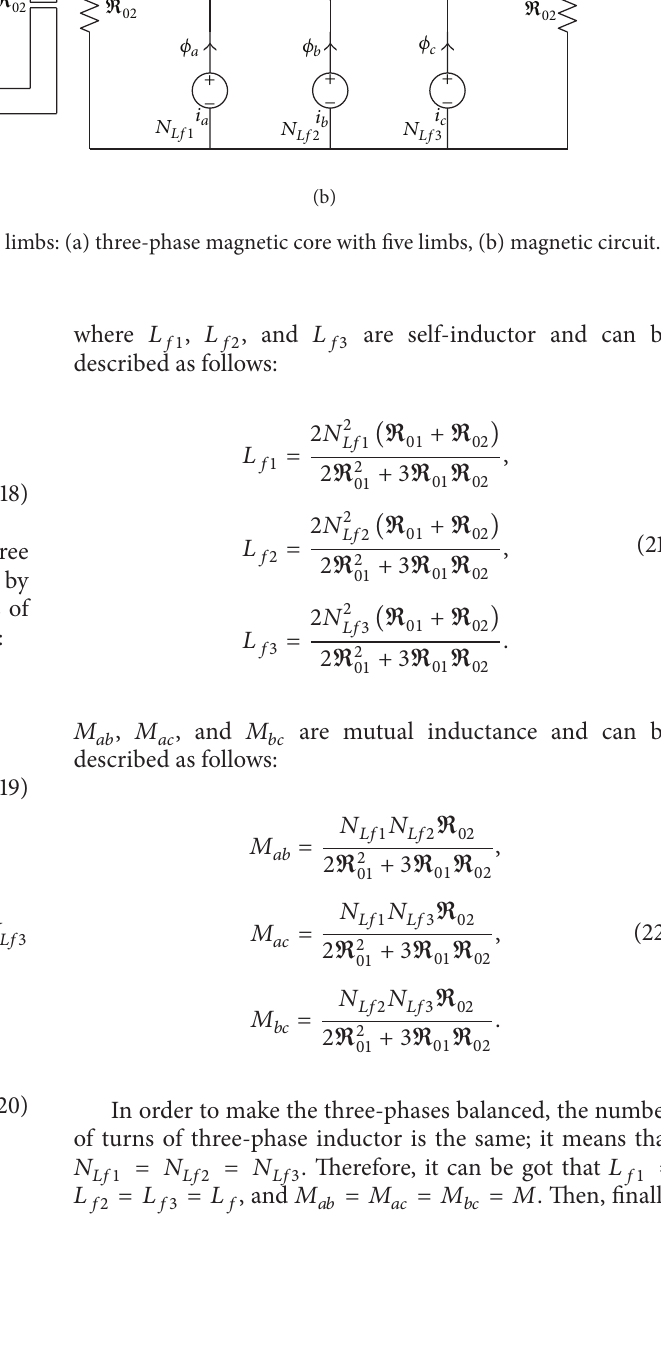
Figure 5: Three-phase integrated inductors with five magnetic limbs: (a) three-phase magnetic core with five limbs, (b) magnetic circuit.